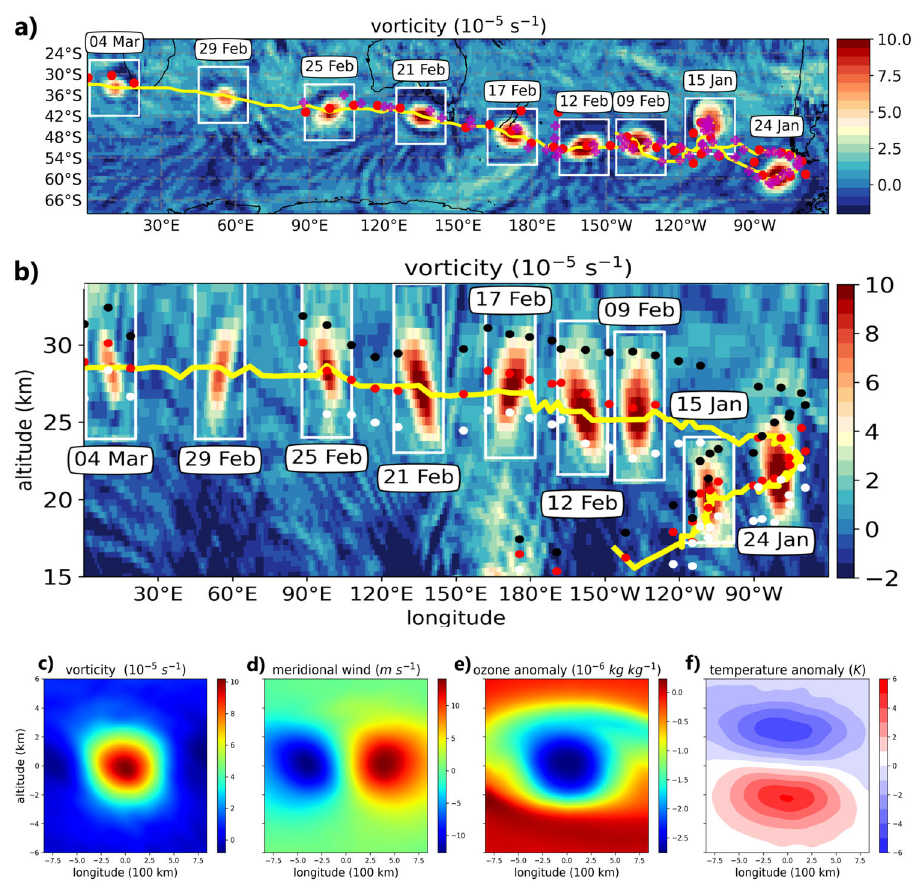
Fig. 6 Spatiotemporal evolution of the vortex and its thermodynamical properties. a Composite horizontal sections of the vortex. The background shows the relative vorticity fi eld on 24 January 2020 6UTC from the ECMWF operational analysis on the surface 46.5 hPa (21.3 km at the location of the vortex) corresponding to the level of highest vorticity in the vortex. The boxes show the vorticity fi eld at other times as horizontal sections at the level of maximum vorticity centroid projected onto the background fi eld. The yellow curve is the twice-daily sampled trajectory of the vortex centroid. The red dots show the location of the CALIOP bubble centroid for all the cases where it is clearly intersected by the orbit. The magenta crosses show the location of the center of the compact aerosol index anomaly as seen from TROPOMI (Supplementary notes 3). b Composite vertical section of the vortex. The background is here the longitude-altitude section of the vortex on 24 January 2020 6 UTC at the latitude 47°S. The boxes show vertical sections at the same time as ( a ) at the latitude of maximum vorticity. The black, red and white dots show, respectively, the CALIOP bubble top, centroid and bottom. c Composite of the vortex vorticity in the longitude – altitude plane at the level and at the latitude of the vortex centroid performed during the most active period of the vortex between 14 January and 22 February. d Same as ( c ) for the meridional wind deviation with respect to the mean in the displayed box. e Same as ( c ) but for the ozone mixing ratio deviation with respect to the zonal mean. f Same as ( c ) but for the temperature deviation with respect to the zonal